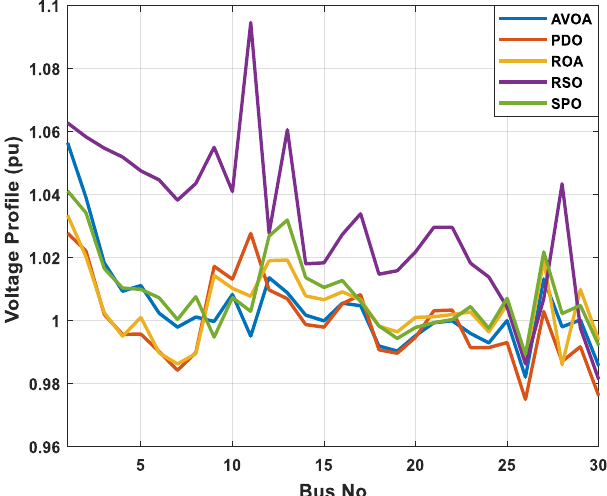
Figure 6. The AVOA voltage profile with the other compared methods for case 2.